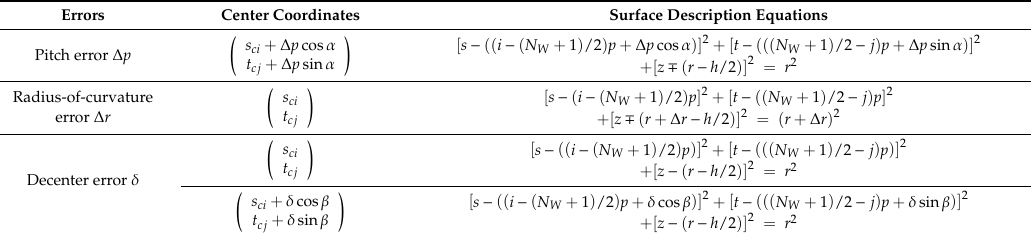
Table 1. Mathematical Model of MLA form error.